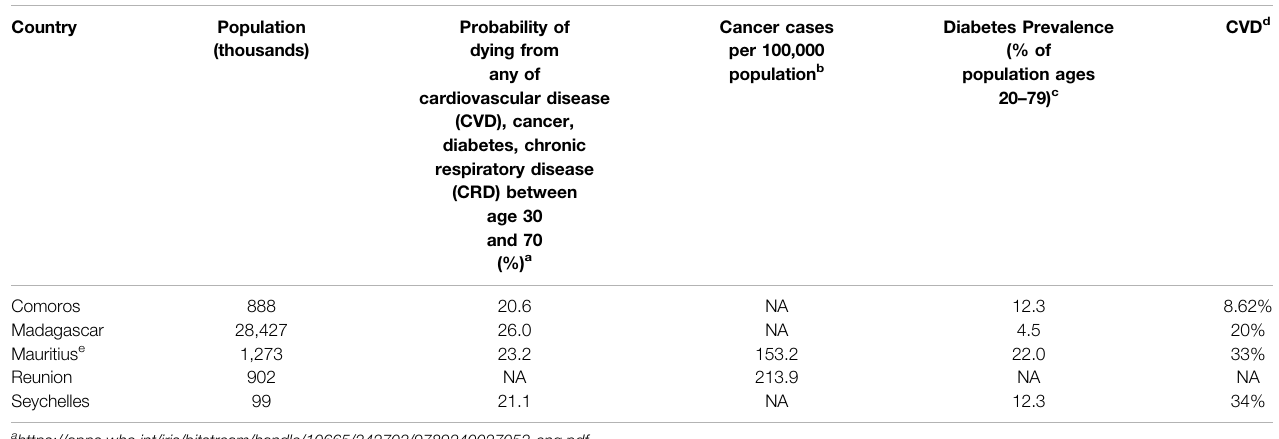
TABLE 2 | Prevalence of diseases. Country Population